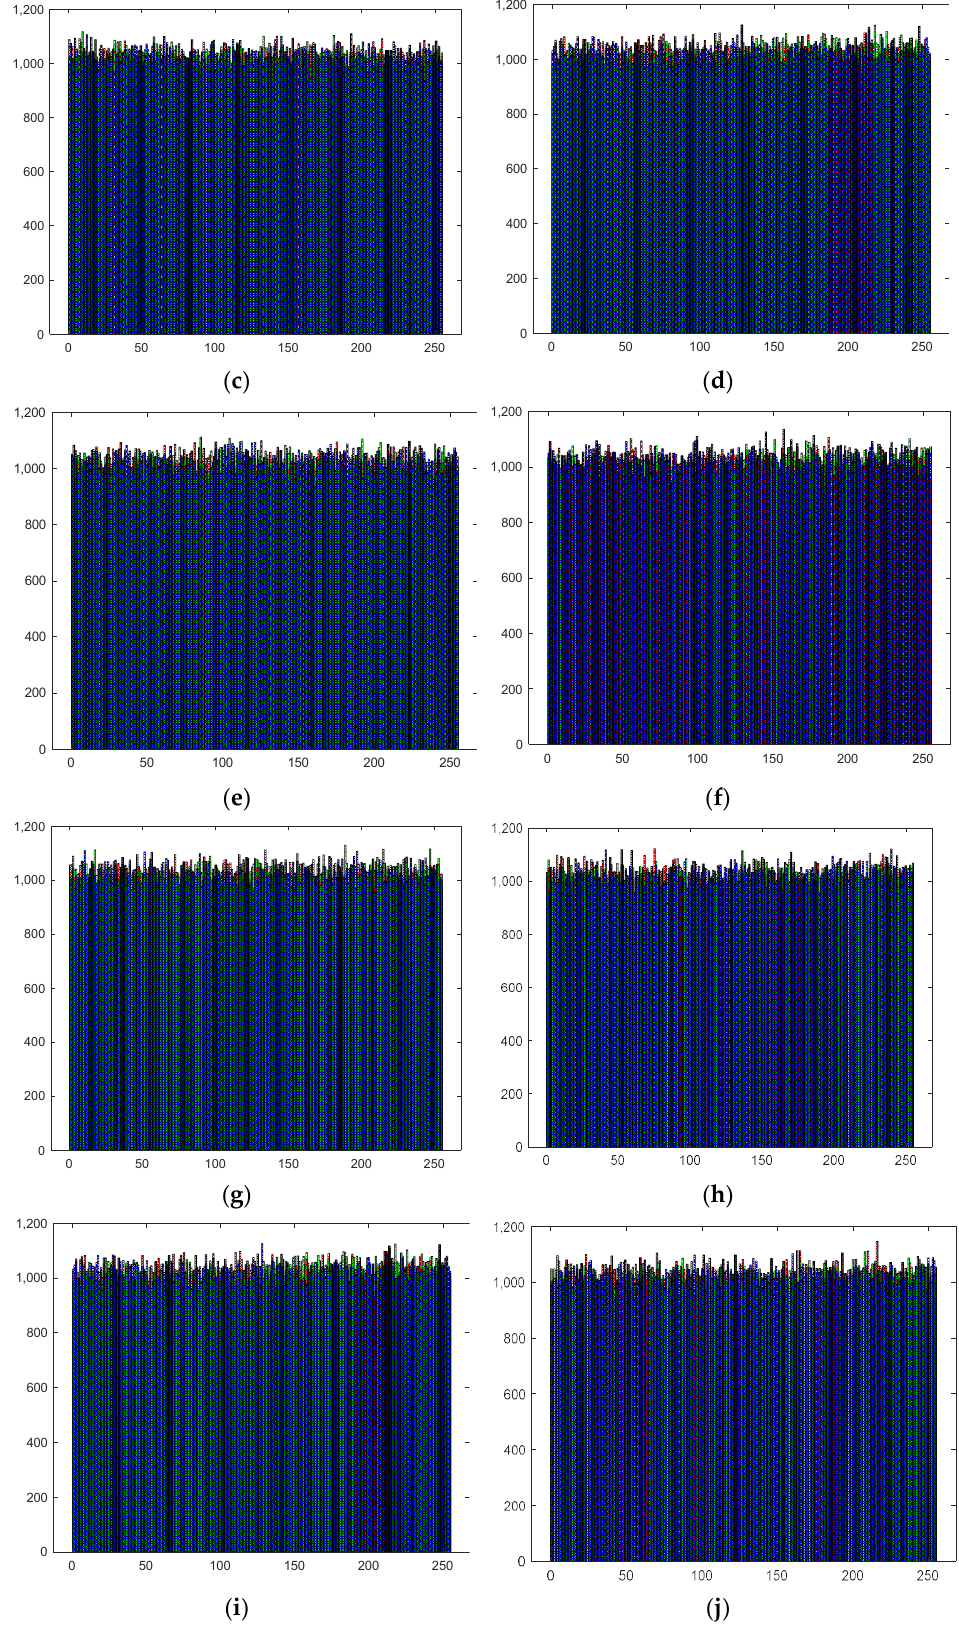
Figure 17. The histograms of encrypted images: ( a ) histogram of encrypted Peppers; ( b ) histogram of encrypted Baboon; ( c ) histogram of encrypted Airplane; ( d ) histogram of encrypted House; ( e )